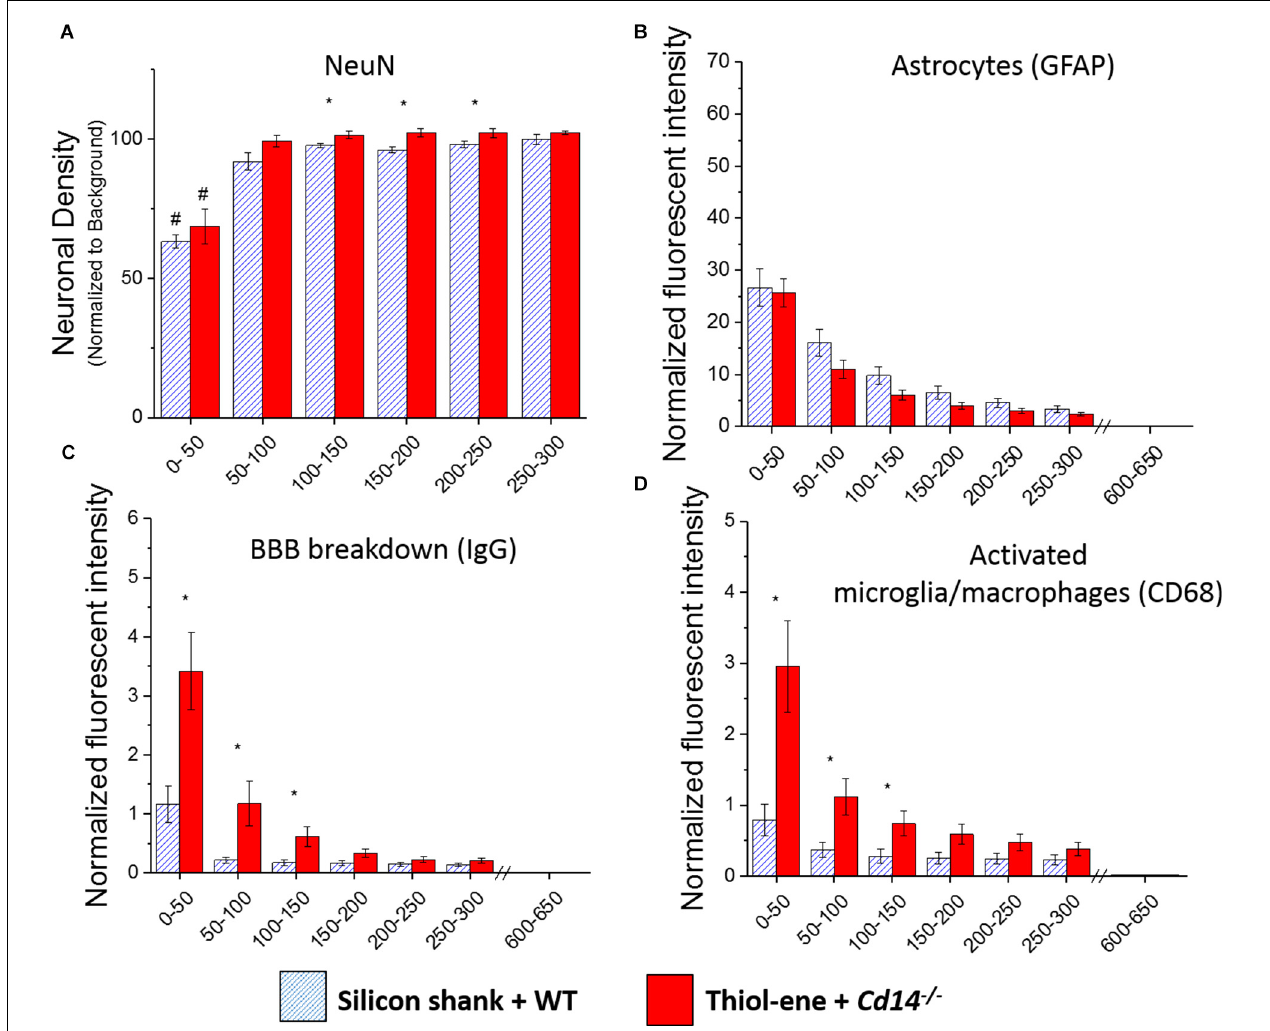
FIGURE 1 | Immunohistochemical evaluation comparing the dual targeting of the innate immune response and mechanical mismatch to control at 2 weeks after implantation. All analyses were evaluated with respect to distance from the explanted microelectrode hole ( µ m). (A) Neuronal density evaluated as NeuN + cells. (B) Astrocyte encapsulation evaluated as GFAP expression. (C) Blood-brain barrier permeability evaluated as IgG expression. (D) Microglial and macrophage activation evaluated as CD68 expression. ∗ Denotes significance between silicon shank + WT and thiol-ene + Cd14 − / − ; # denotes significant difference from background neuronal